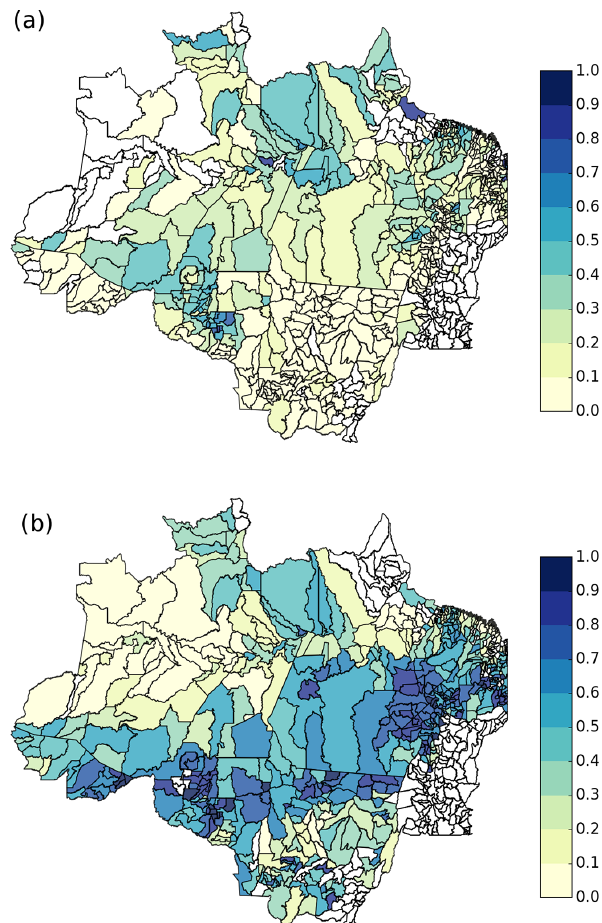
Figure 4. Map of two selected components of the conditional tran- sition matrices q for each municipality of the Brazilian legal Ama- zon. Colors indicate the shares of areas that make a transition from (a) clean pasture to secondary vegetation and (b) secondary vegeta- tion to clean